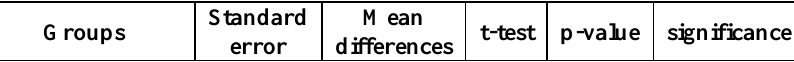
Table 12: t-test analysis of water solubility